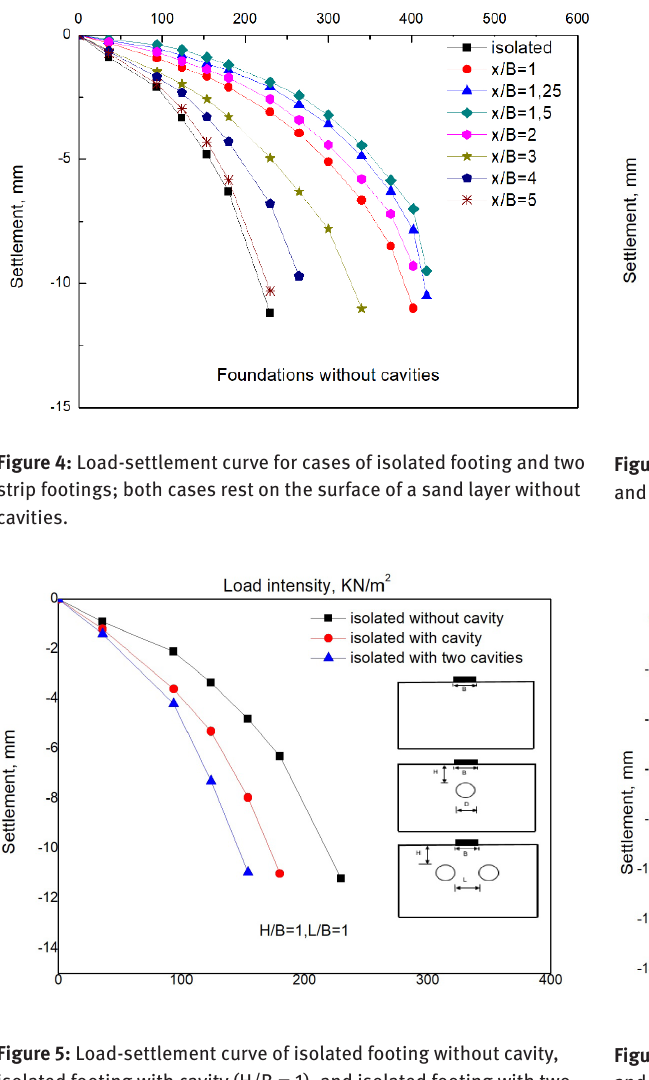
Figure 7: Load-settlement curve of adjacent footings without cavity and case of adjacent footings with two cavities (H/B = 1 and L/B =